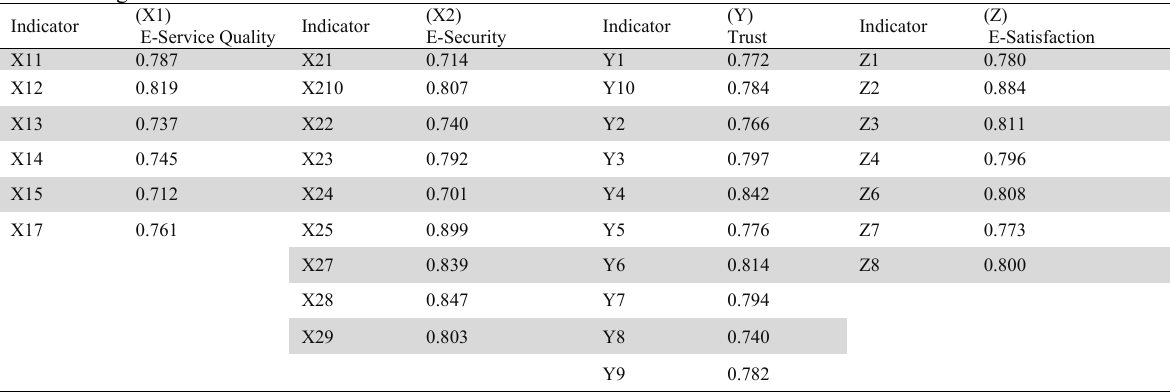
Outer loading test